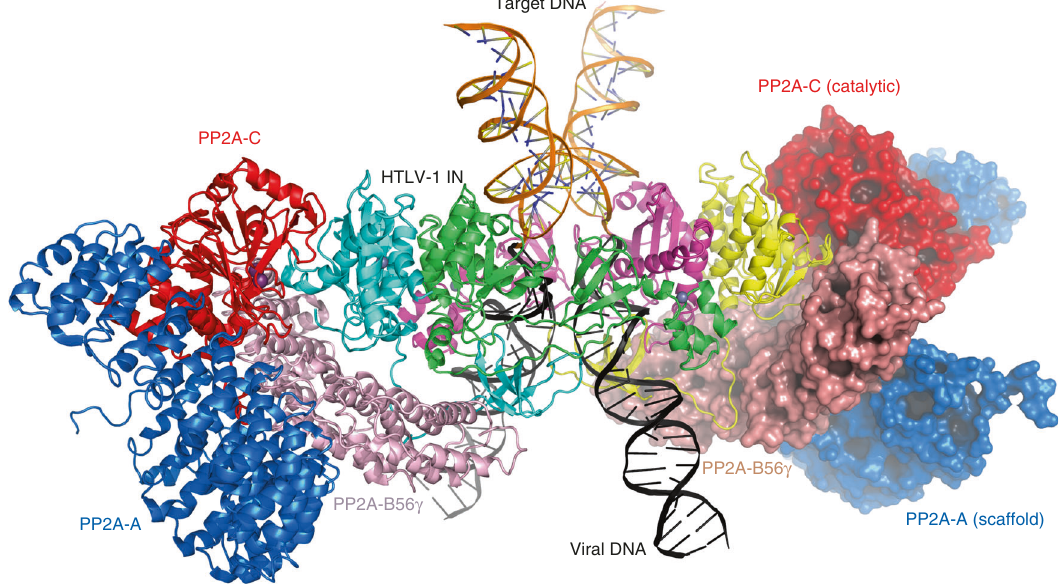
Fig. 4 A hypothetical model of HTLV-1 intasome containing PP2A holoenzymes. Two copies of PP2A holoenzyme 50 were docked on the HTLV-1 intasome by superposition of the B56 γ subunits, resulting in a snug fi t between the catalytic C subunit of PP2A (red) and the catalytic domain of outer IN subunit (yellow and